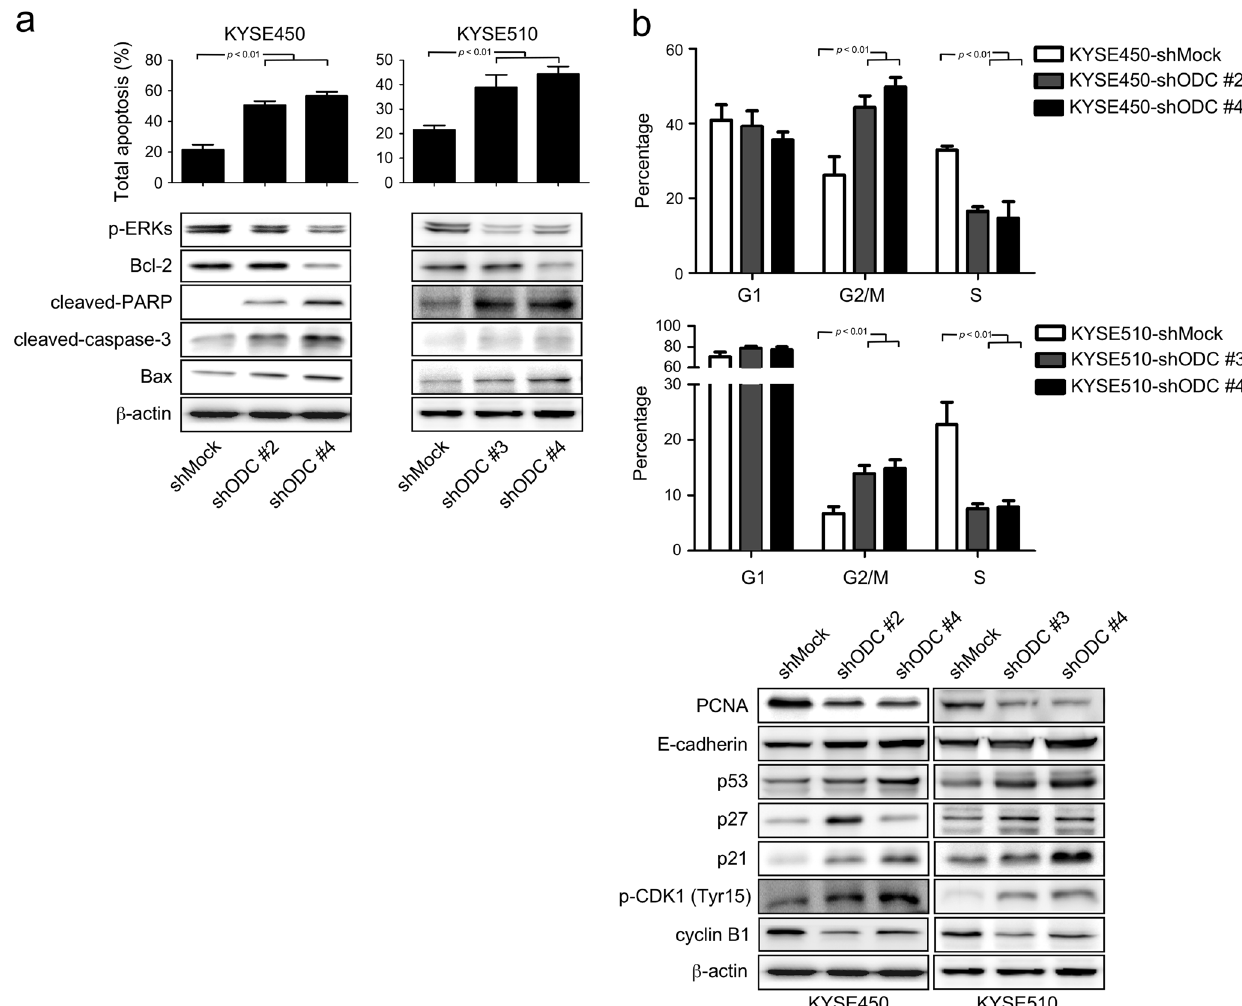
Western blot ( lower panels) . All data are shown as means ± S.D. of triplicate values from 3 independent